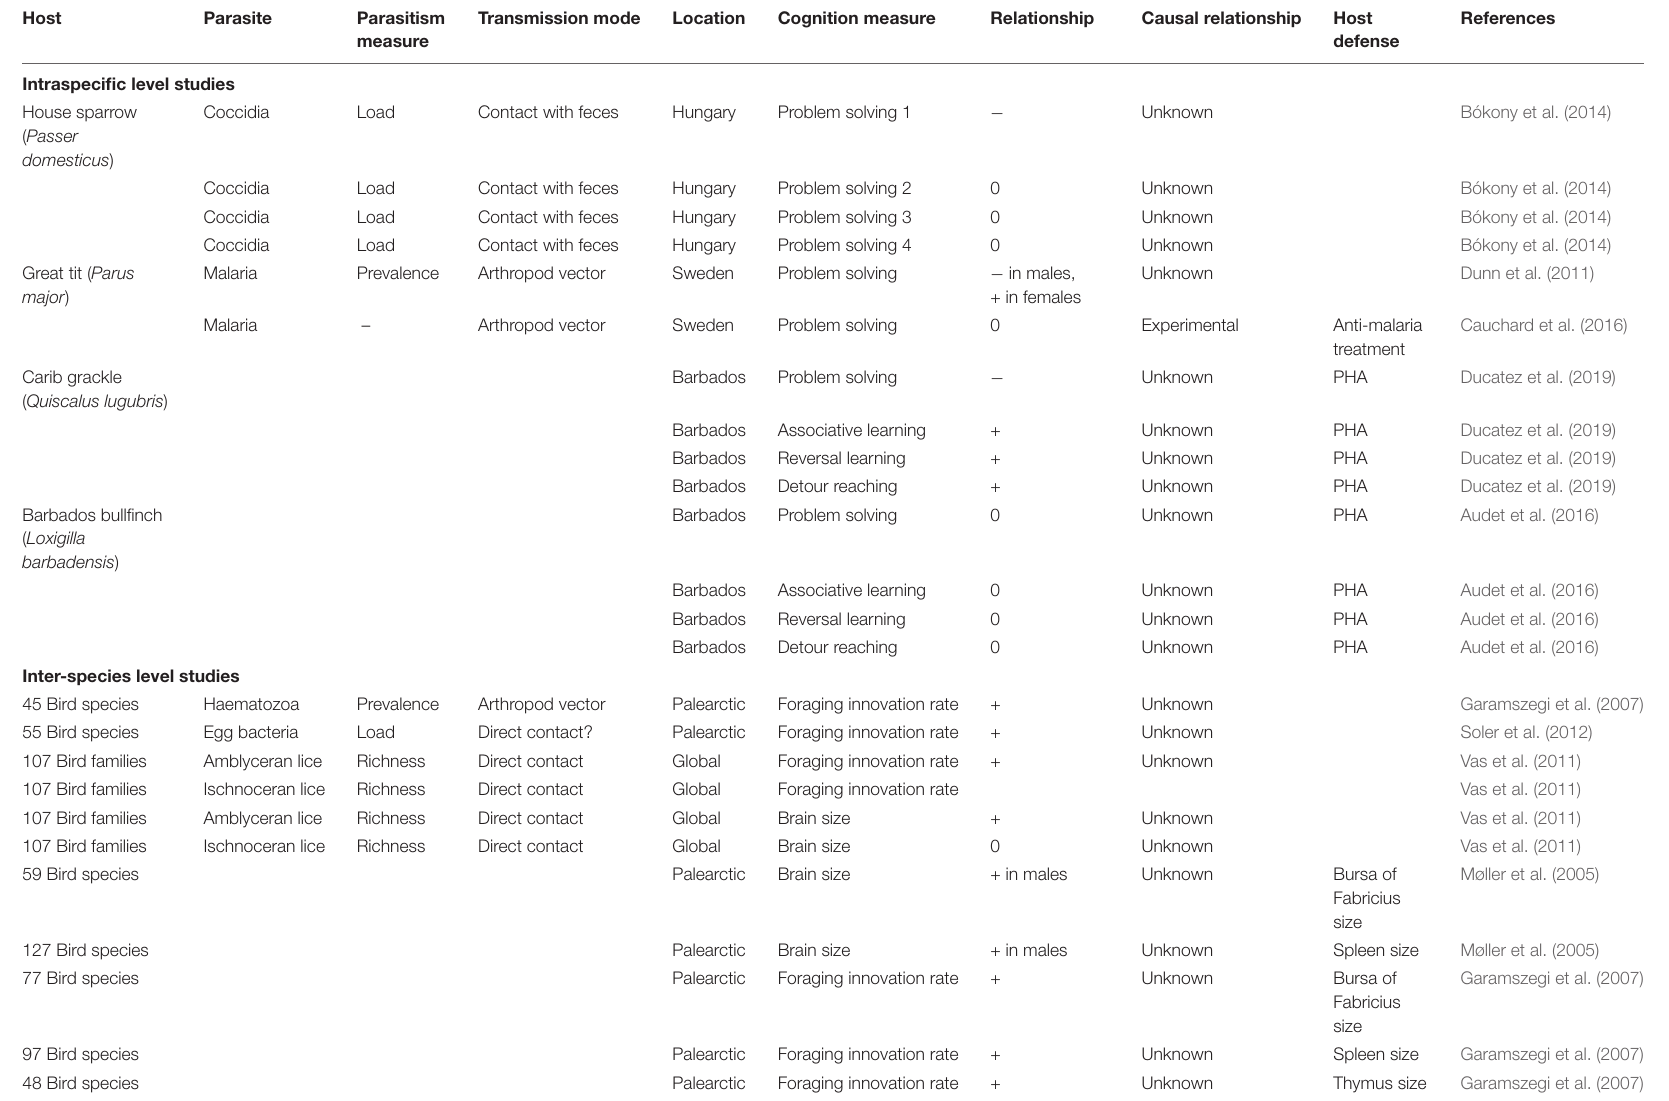
TABLE 1 | Patterns of covariation between cognitive traits and parasitism or host defense in wild birds from studies considering intraspecific or interspecific variation.